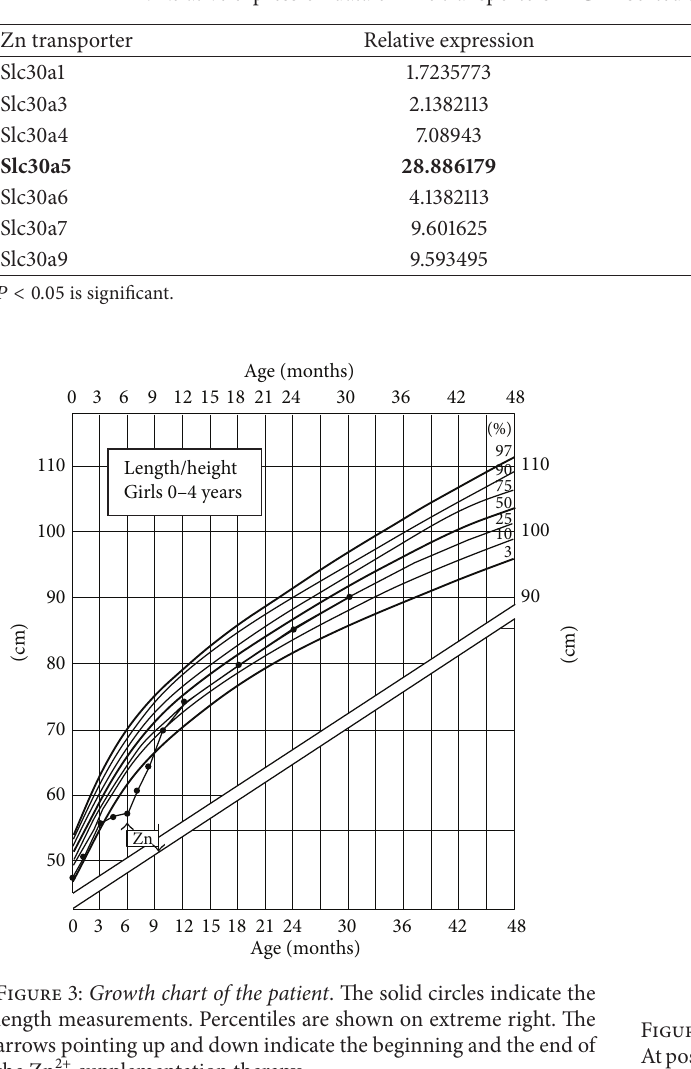
Table 2: Relative expression data of zinc transporters in GFP-sorted somatotrope cells from GH-eGFP transgenic mouse.